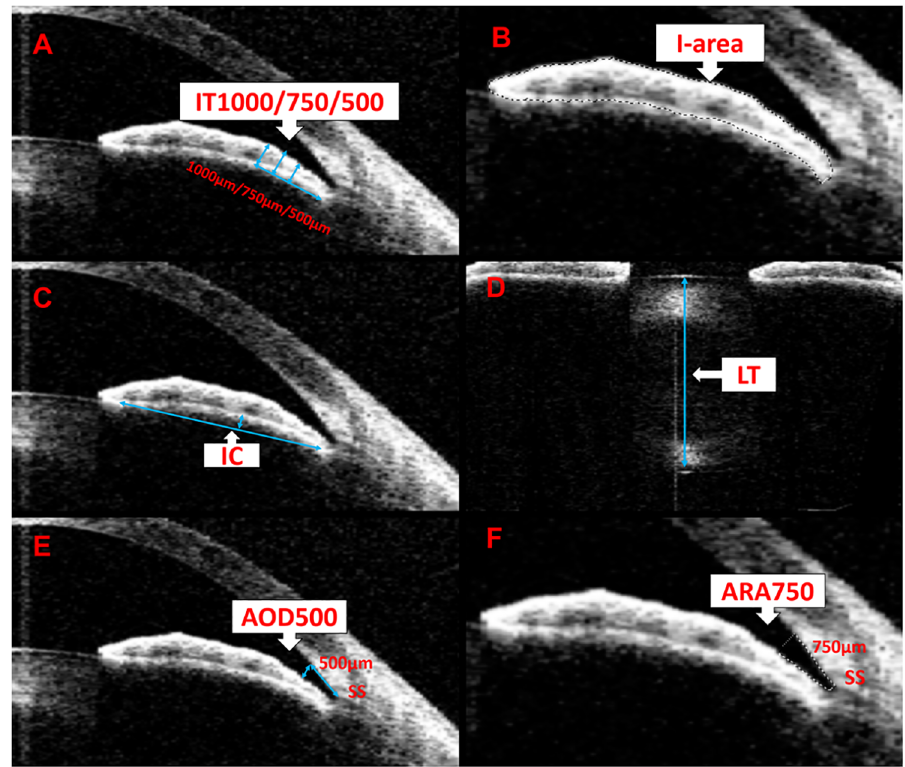
Fig 2. Determinations of AOD500 μ m, IT500 μ m/750 μ m/1000 μ m,IC, LT, ARA750 μ m, and I-area by AS-OCT. A: Iris thickness at 500, 750, and 1000 μ m (IT500 μ m,IT750 μ m, and IT1000 μ m,respectively) were definedas the perpendicular distancefrom the point at iris pigmentepitheliumanterior to the iris surface at 500, 750, and 1000 μ m from the iris root, respectively. B: Iris area (I-area) was definedas the cross-sectional area of the iris. C: Iris curvature (IC) was definedas the maximum perpendicular distancebetweenthe iris pigmentepitheliumand the line connectingthe most peripheral to the most central point of the epithelium. D: Lens thickness (LT) was definedas the maximum perpendicular distancebetweenthe anterior and posterior poles of the lens. E: Angle opening distanceat 500 μ m (AOD500 μ m) was definedas the perpendicular distancefrom the point anterior to the scleral spur to the anterior iris surface at 500 μ m from the scleral spur. F: Angle recess area at 750 μ m (ARA750 μ m) was definedas the enclosedtriangulararea demarcated by the anterior iris surface, trabecular meshwork, and cornealendotheliumto a distanceof 750 μ m from the scleral spur.